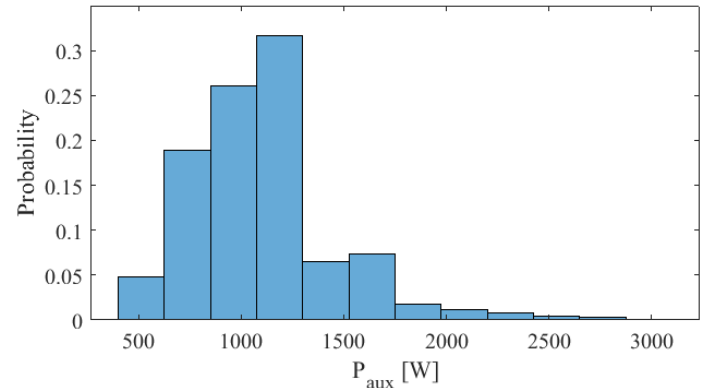
Figure 11. Distribution of experimental observations for auxiliaries’ power.